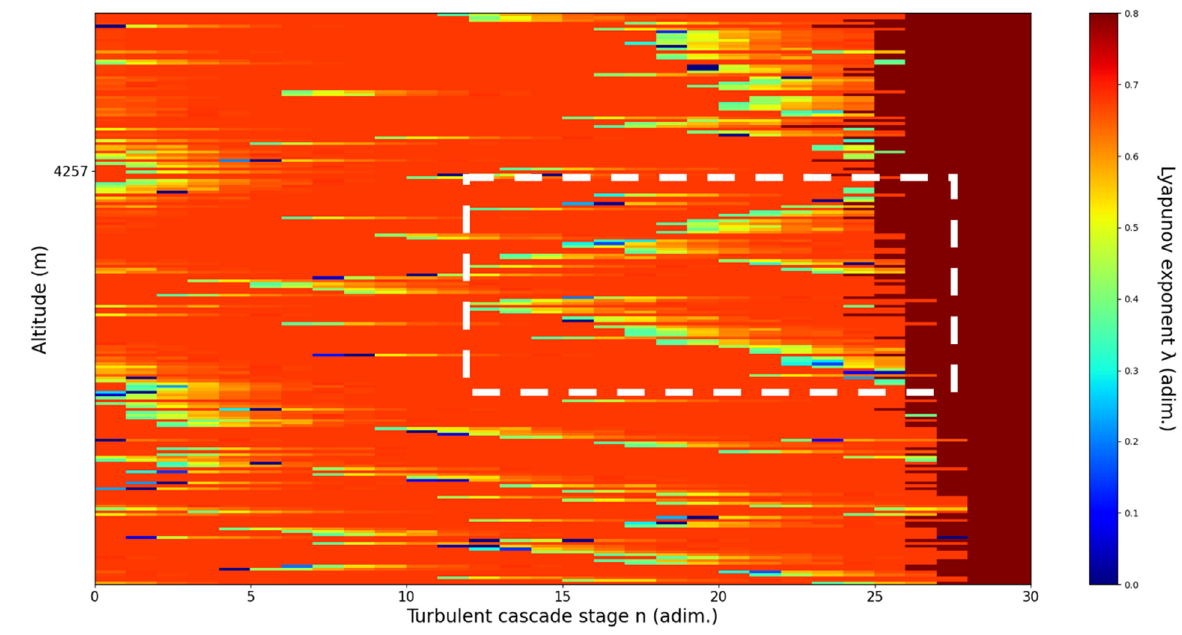
Figure 12. Lyapunov exponent per turbulent cascade stage colormap altitude plot, Bucharest, Romania, 13 June 2019,